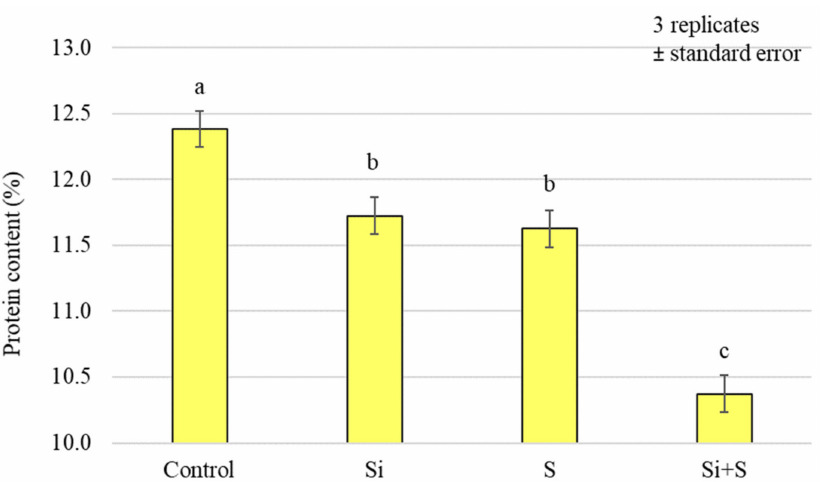
Figure 7. Protein content of the winter oat whole grains as a function of foliar fertilisation treatments; ± standard error of means. 3 replicates. The different letters show significantly differing values, at p = 0.05